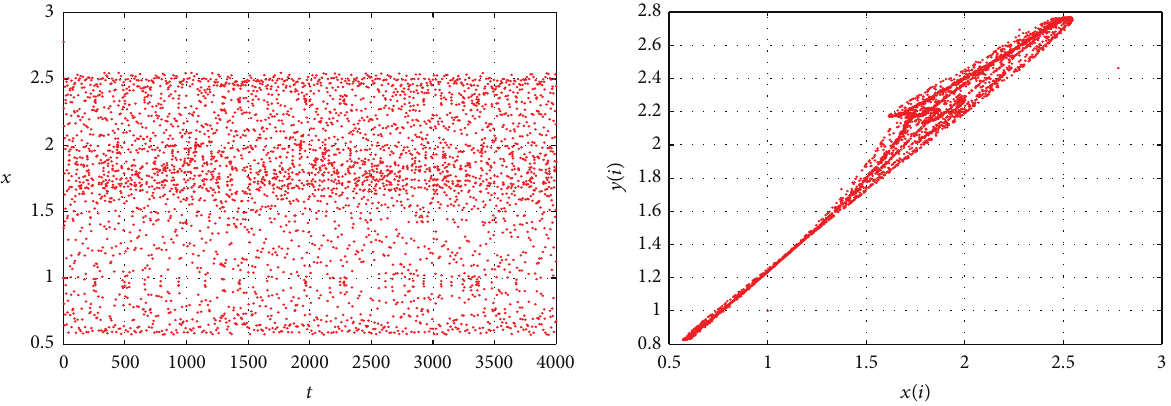
Figure 2: The portraits for several values of 𝐴 1 = 0.18 , 𝛿 = 6.45